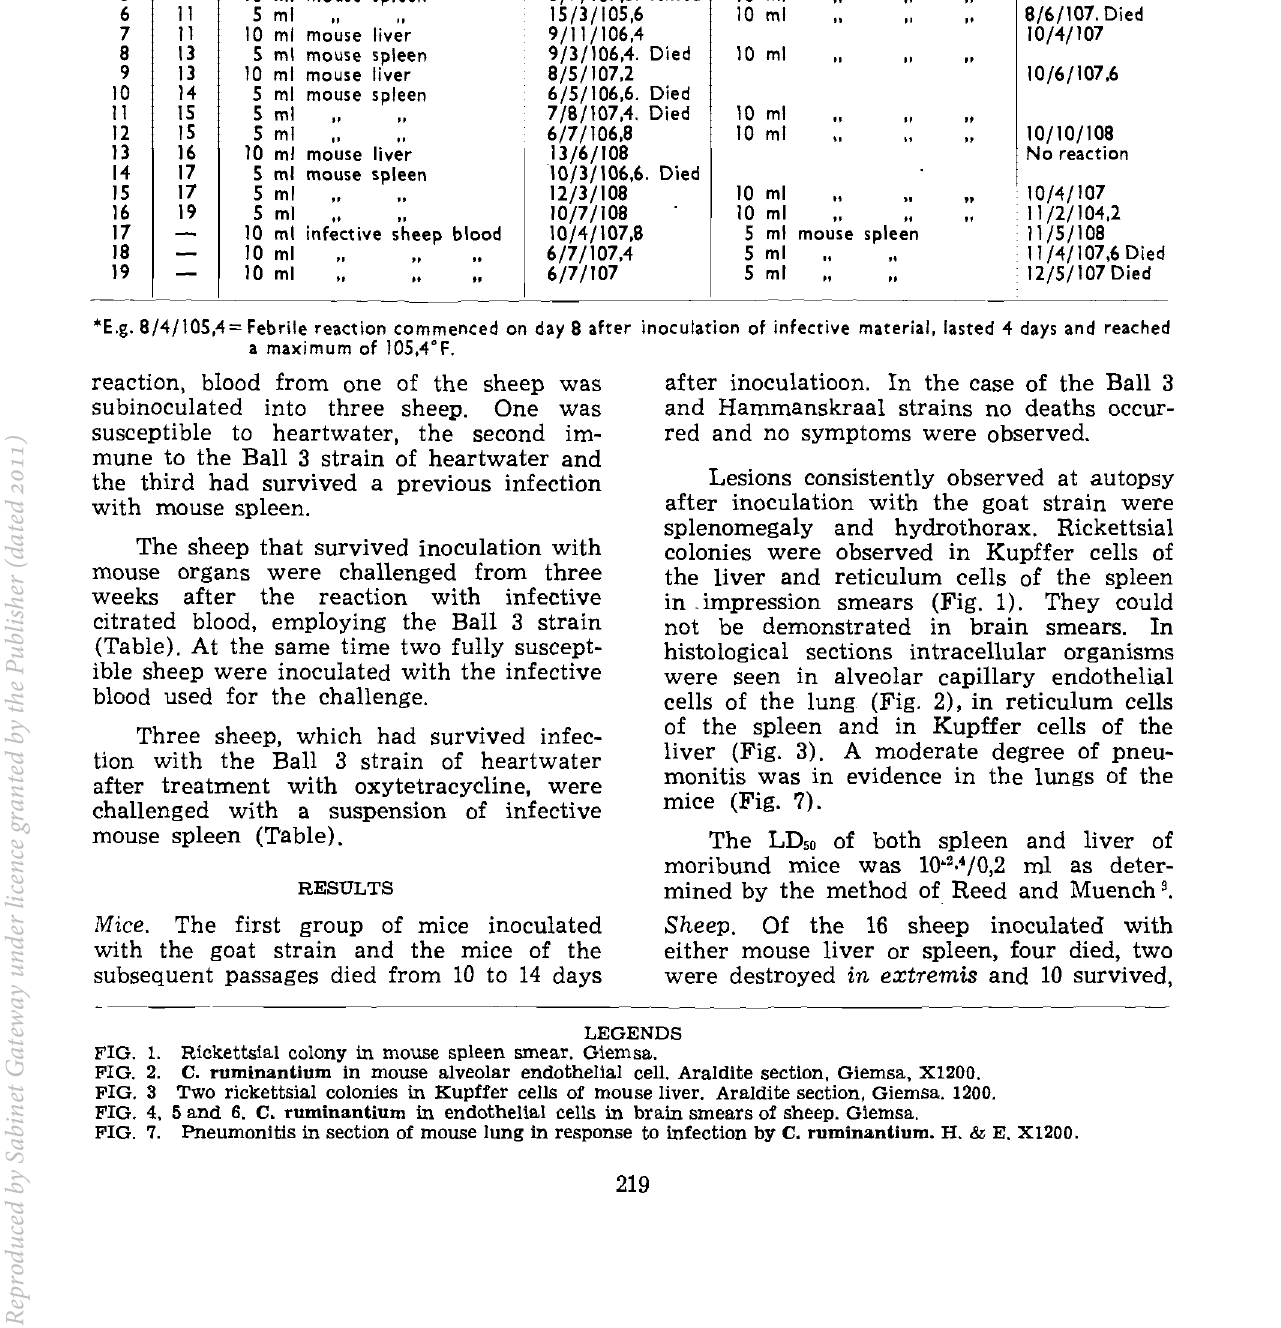
FIG. 3 Two rickettsial colonies in Kupffer cells of mouse liver. Araldite section. Giemsa. 1200. FIG. 4. 5 and 6. C. ruminantium in endothelial cells in brain smears of sheep. Giemsa. FIG. 7. Pneumonitis in section of mouse lung in response to infection by C. ruminantium. H. & E.